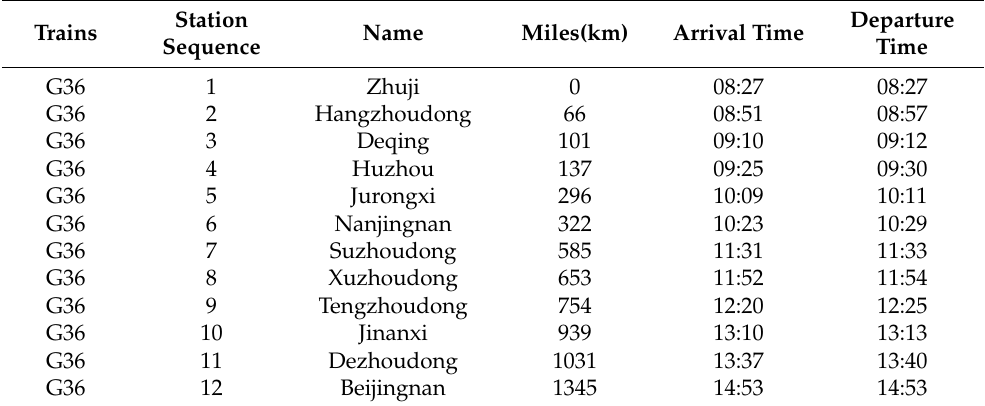
Table 1. Example of HSR trip